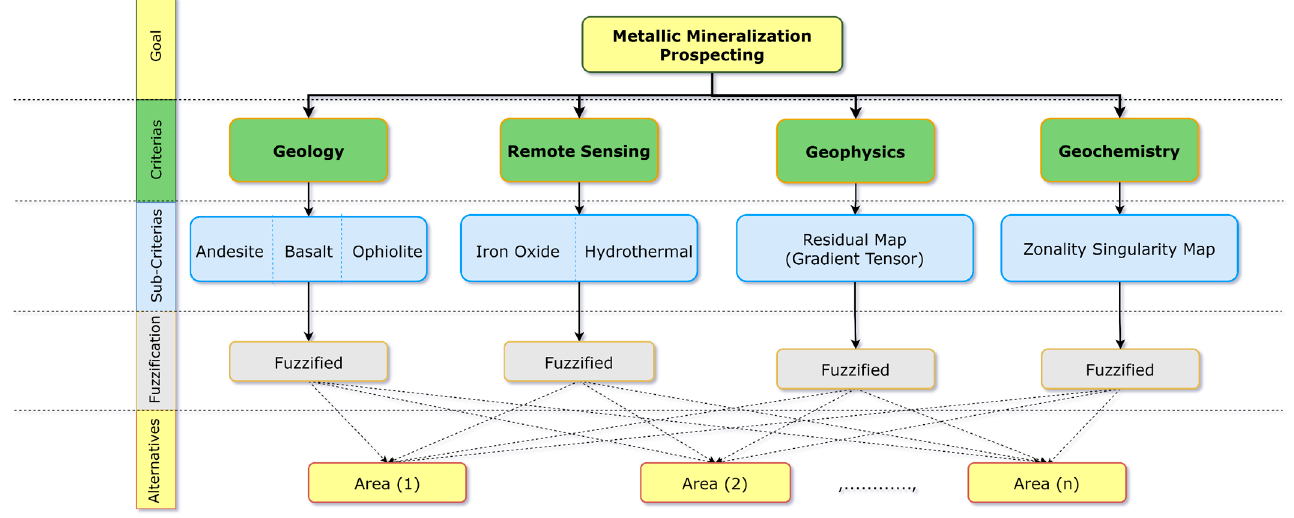
Figure 20. Hierarchical diagram of the fuzzy-AHP hybrid method and criteria and sub-criteria con-